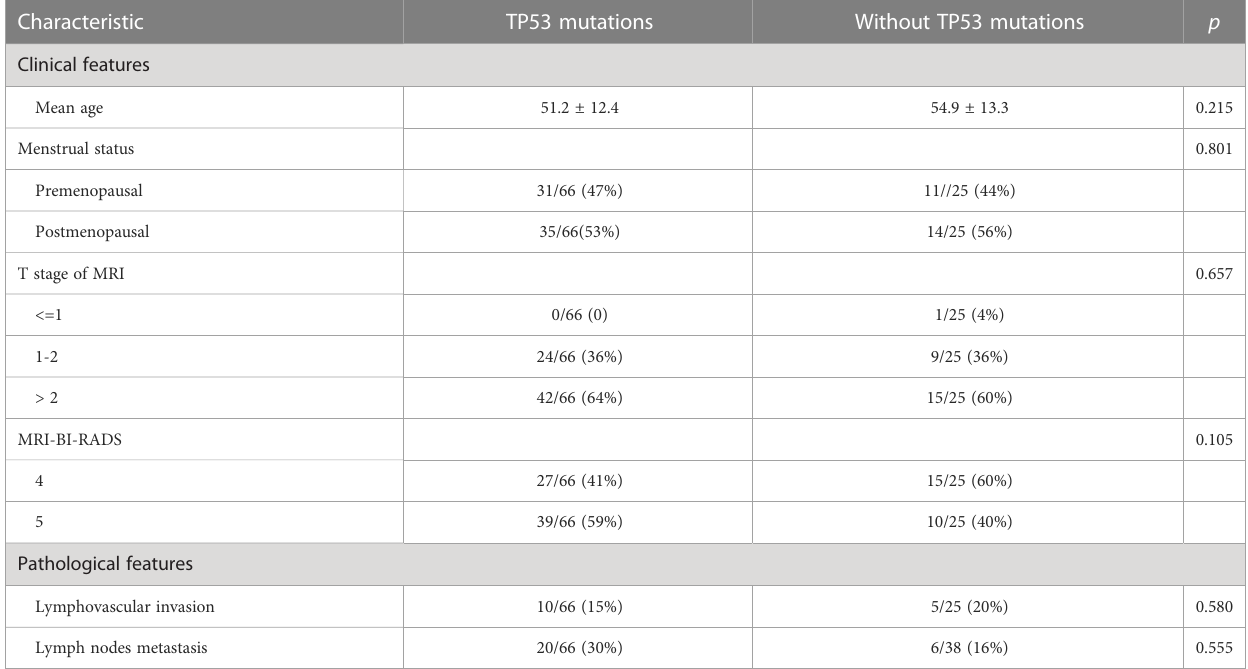
TABLE 1 The clinico-pathological features of TNBC patients with TP53 mutations and without TP53 mutations.